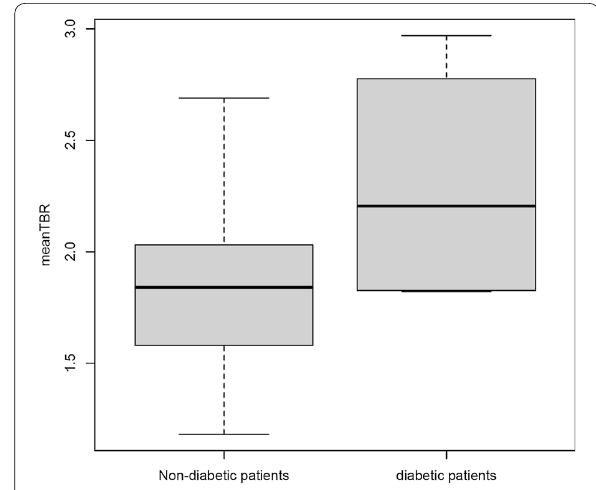
Fig. 4 Box plot showing mean TBR for all patients, separated into non-diabetic patients and diabetic patients